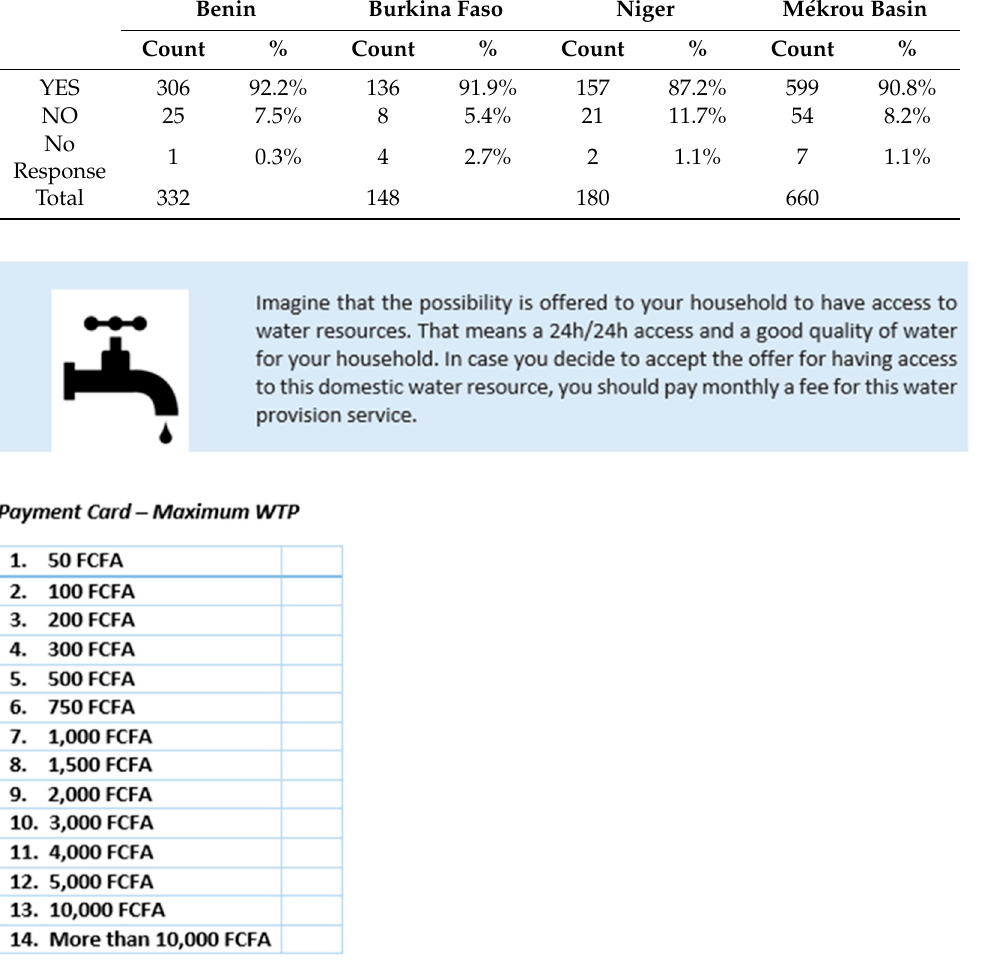
Figure 3. Hypothetical WTP scenario for the Domestic water Figure 3 . Hypothetical WTP scenario for the Domestic water provision.